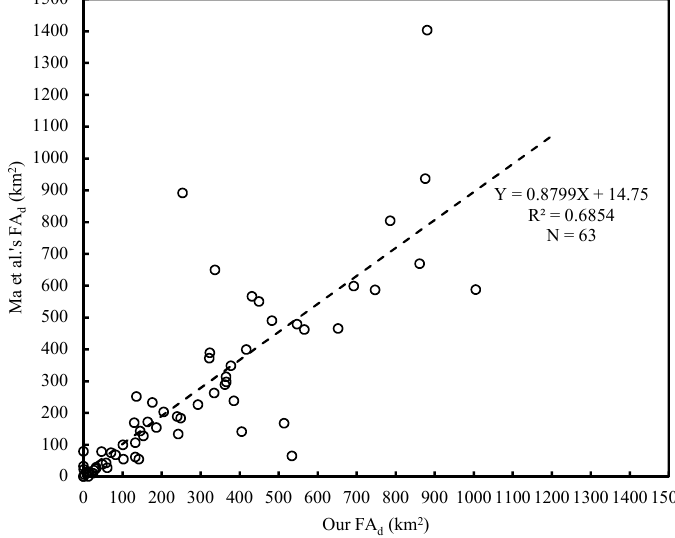
Figure 5. Scatter plot of our daily cyanobacteria bloom areas (FA d ) versus that of Ma et al.